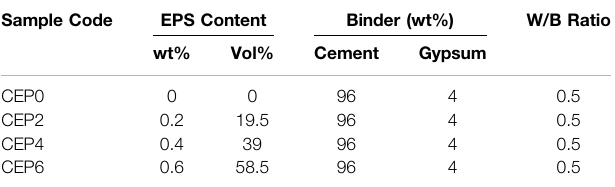
TABLE 1 | Mix proportions and dimensions of the studied specimens.